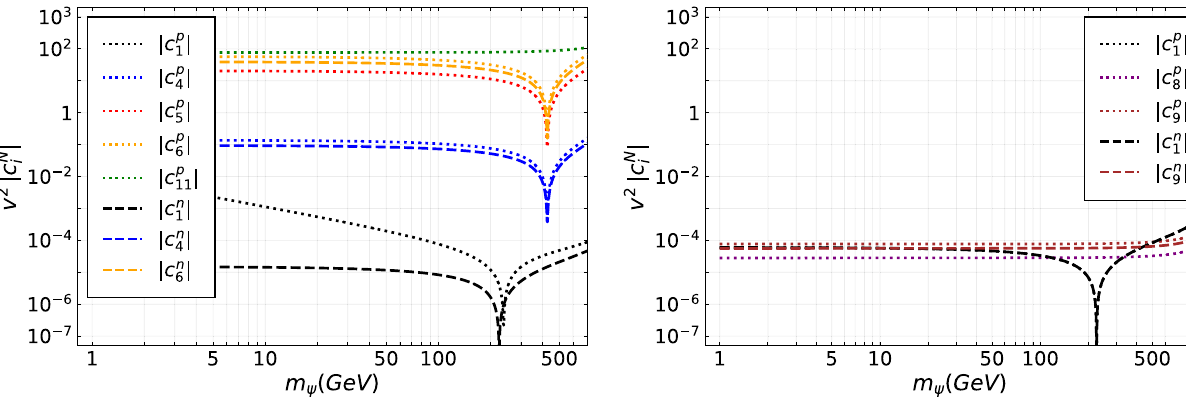
Fig. 1 Dirac DM (top) and Majorana DM (bottom) with a vector- like fermion F of mass m F = 600 GeV and a scalar S of mass m S = 500 GeV. The Yukawa couplings are fixed to y V = 1 and y A = 1 . 3 e i 1 . 4 and Higgs portal coupling λ HS = 3. The Wilson coef-